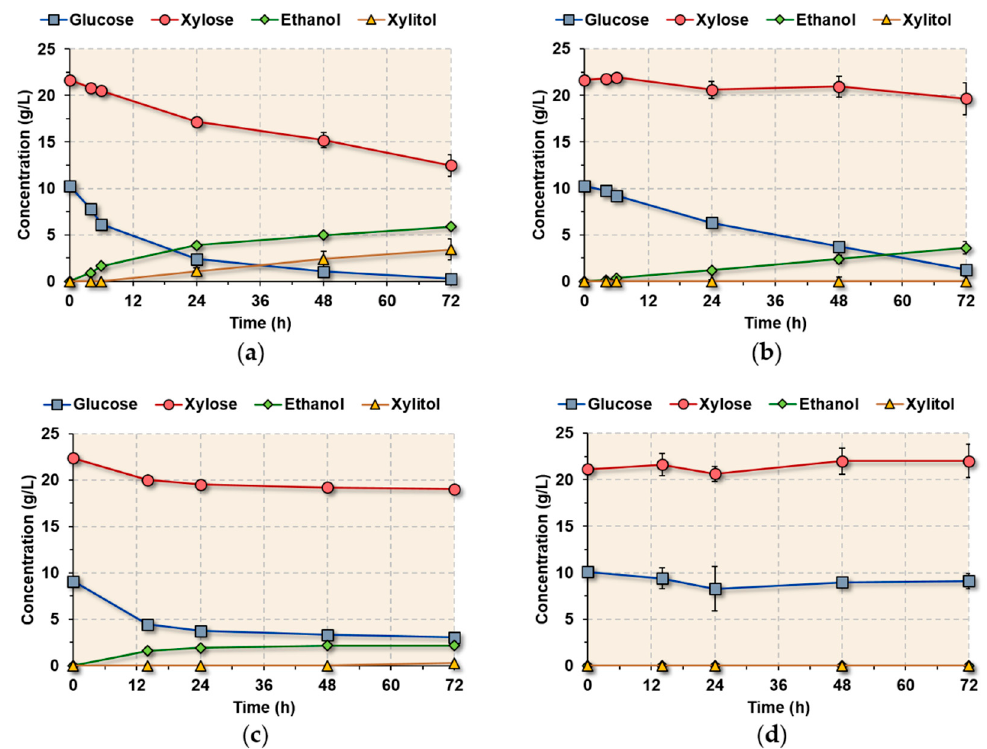
Figure 3. Time course of batch fermentation of wheat straw hydrolysate. Fermentation with ( a , b ) 40% ( v / v ) and ( c , d ) 50% ( v / v ) wheat straw hydrolysate, using ( a , c ) C. intermedia CBS 141442 and ( b , d ) S. stipitis and the error bars indicate the standard deviations. Table 2. Results of fermentation in terms of ethanol yield, xylose consumed and xylitol yield.